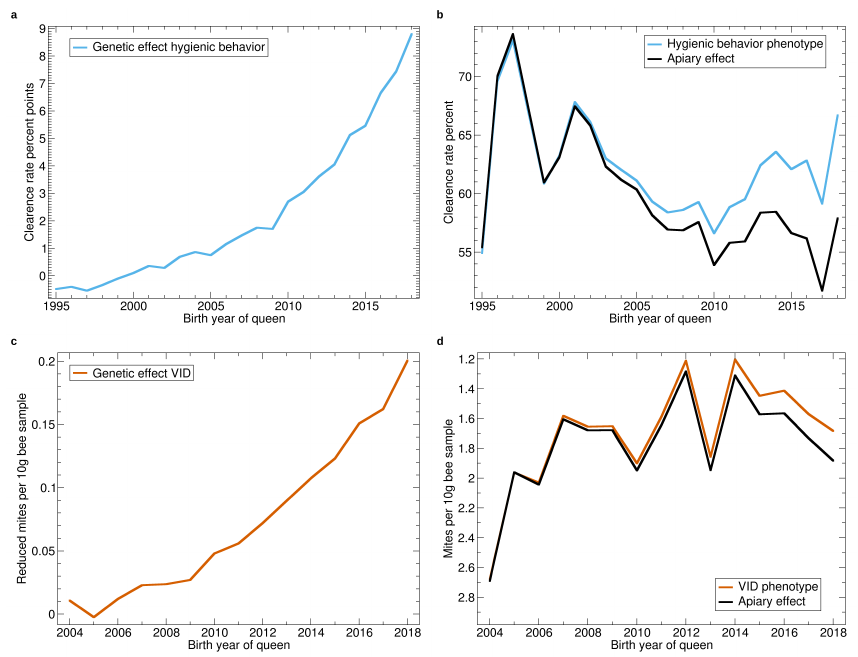
Figure 7. Yearly averages of hygienic behavior and Varroa infestation development (VID). ( a ) Progression of the genetic effect for hygienic behavior. ( b ) Progression of the average apiary effect and phenotype for hygienic behavior. ( c ) Progression of the genetic effect for VID. The trait is inverted, thus, higher values represent improved resistance. ( d ) Progression of the average apiary effect and phenotype for VID. The y-axis is reversed because low infestation development values represent improvement.